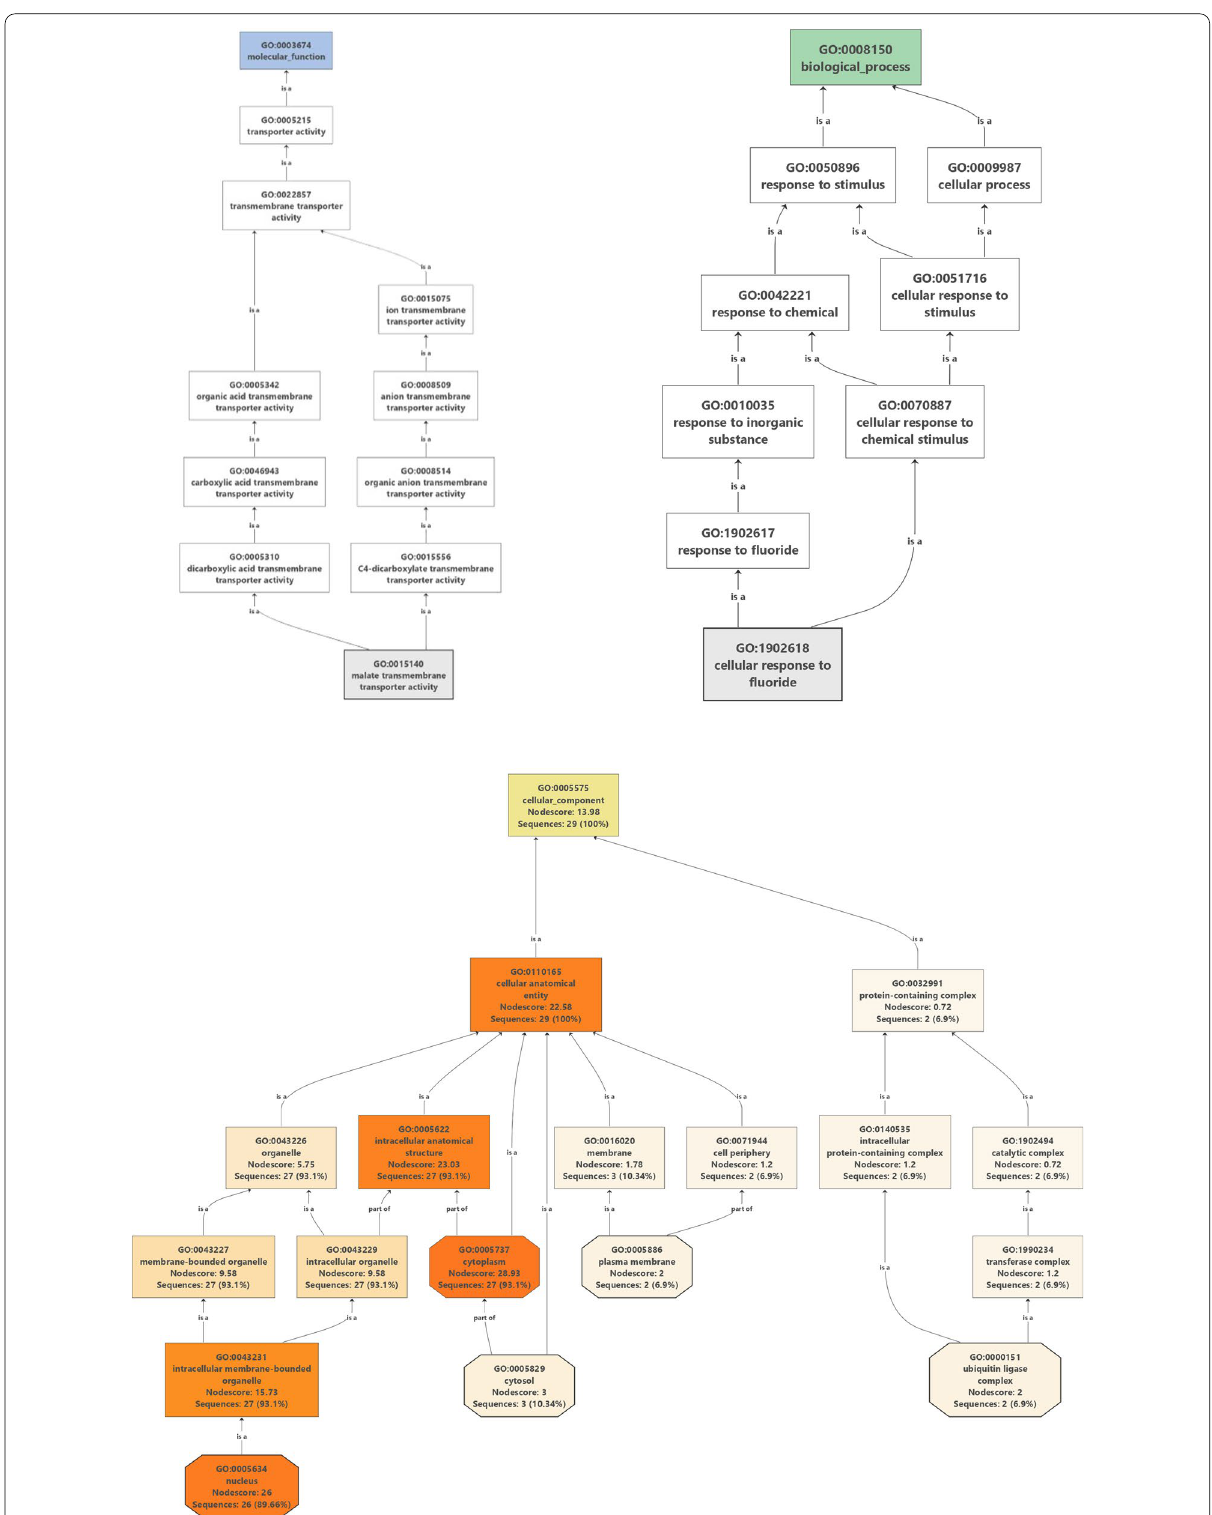
Fig. 10 GO classification of the DEGs in potato. Percentage of the genes in cellular component, molecular function, and biological process classifications are